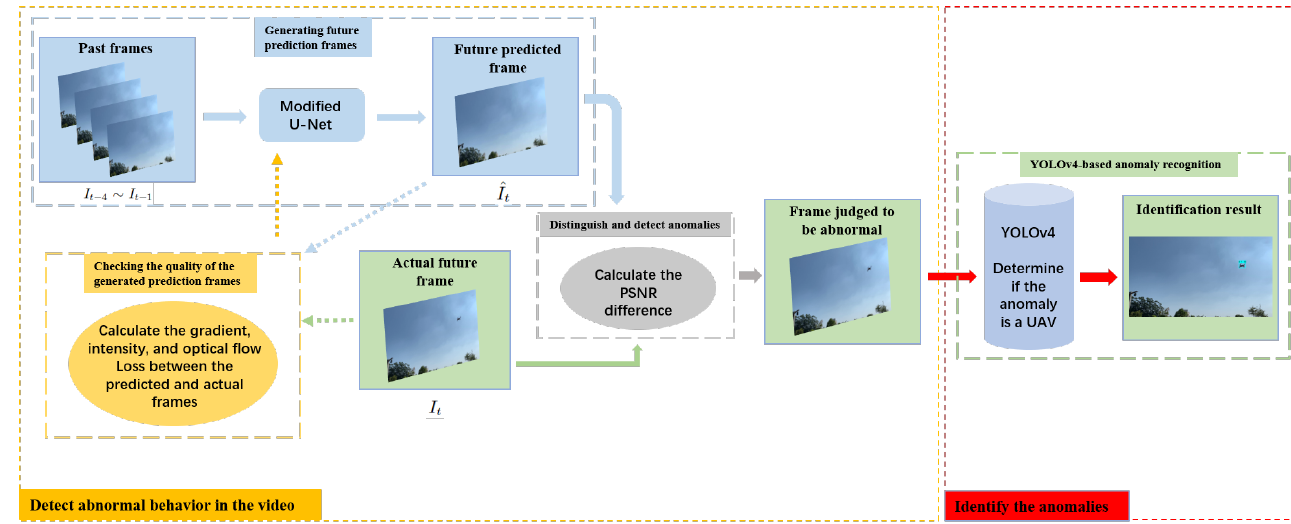
Figure 1. Framework and workflow of CUDM. The goal of the “detect abnormal behavior in the video” stage is to identify the frames containing abnormal objects, and the goal of the “identify the anomalies” stage is to determine whether the abnormal object is a